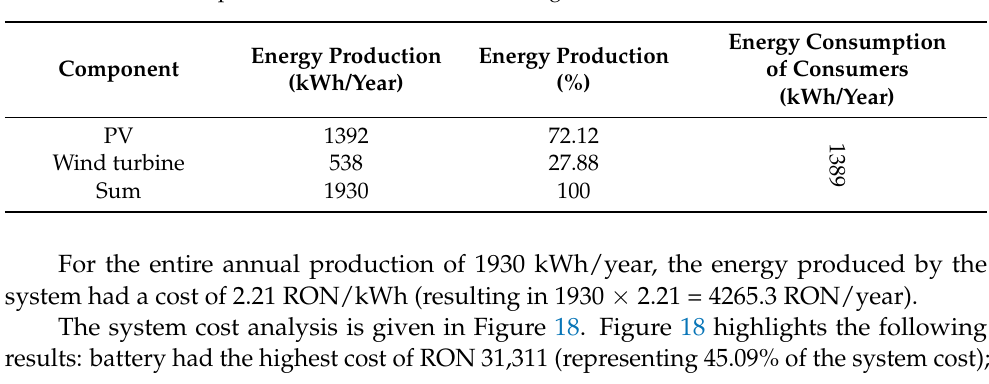
Figure 18. Analysis cost of the system for the third case using iHOGA.